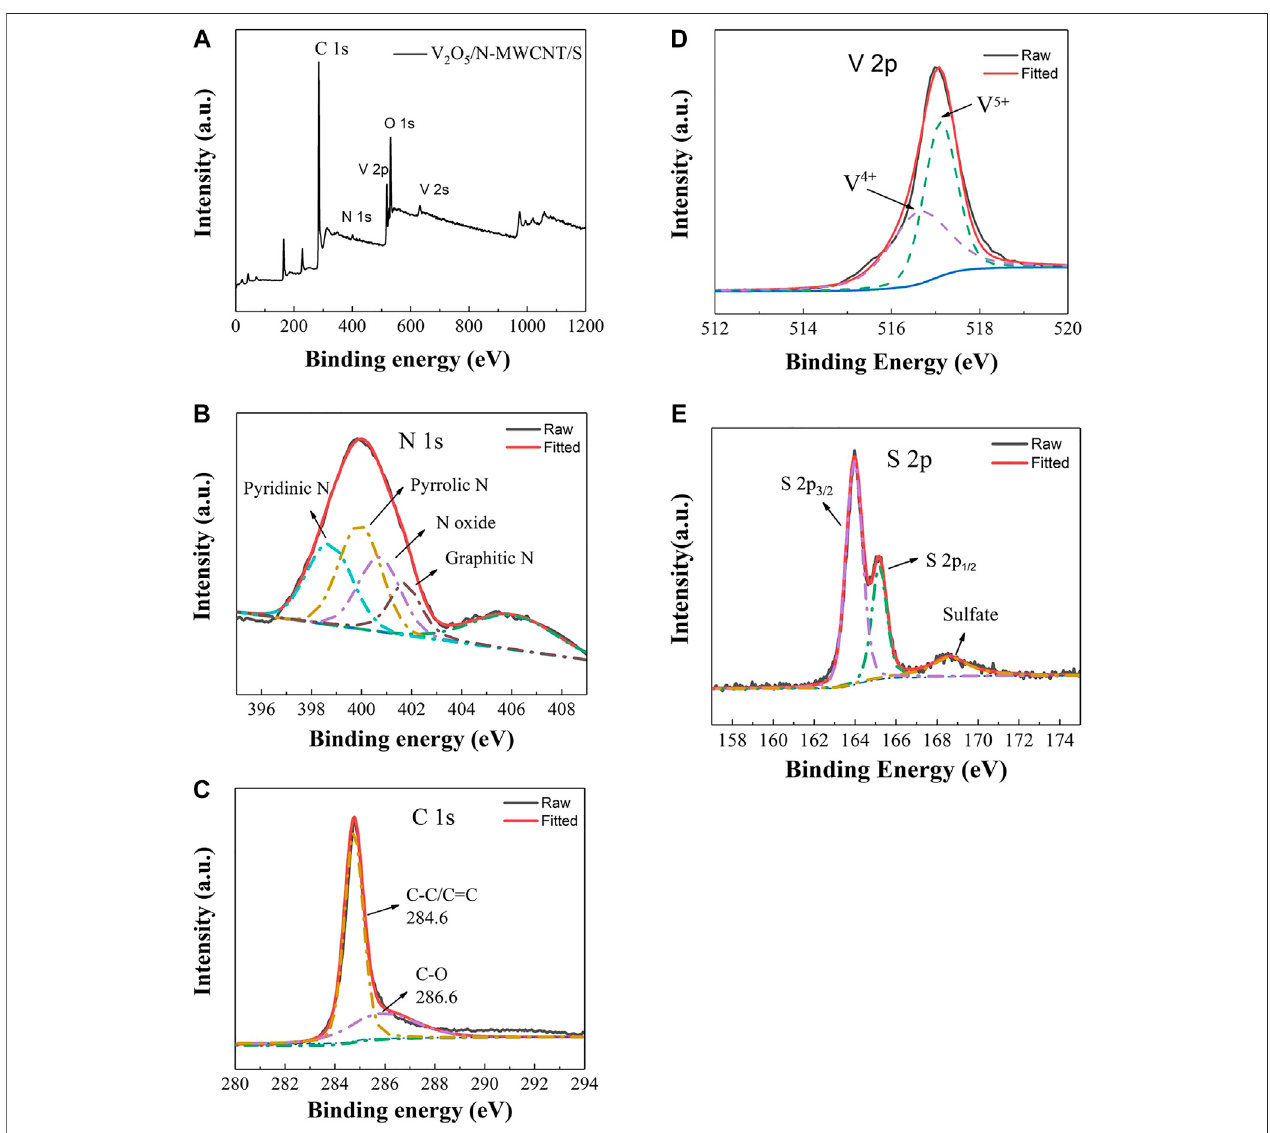
FIGURE 5 | (A) XPS full scan spectra of V 2 O 5 /N-MWCNT/S. (B) High-resolution N 1 s, (C) C 1 s, (D) V2p, and (E) S2p XPS spectra of the V 2 O 5 /N-MWCNT/S composite material.